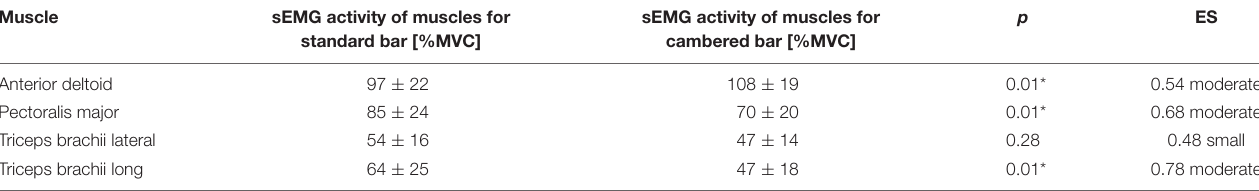
TABLE 2 | The result of main differences in sEMG activity of muscles during the bench press exercises at loads 50%, 70%, 90% 1RM with standard and cambered bar. Muscle